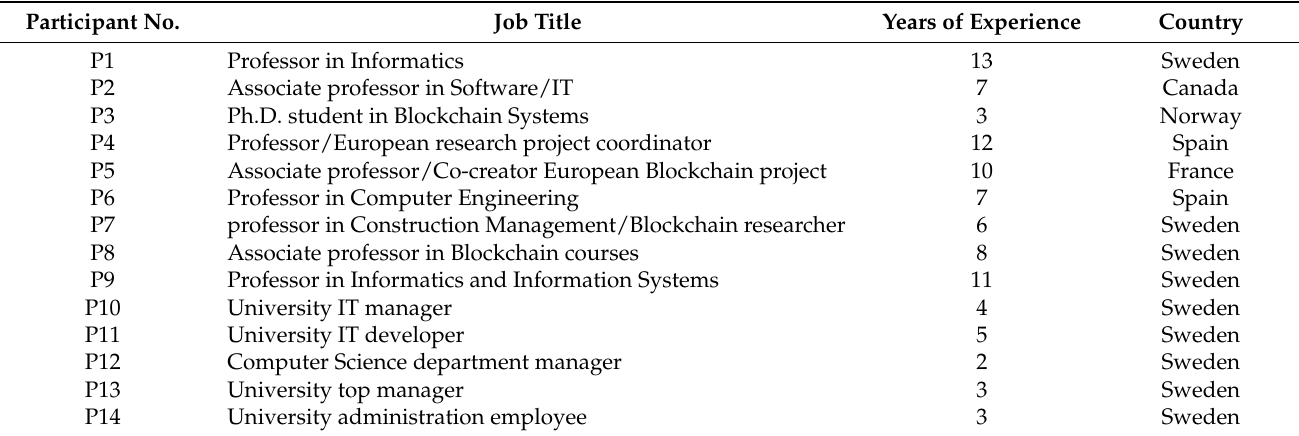
Table 1. Key summary details for each of the 14